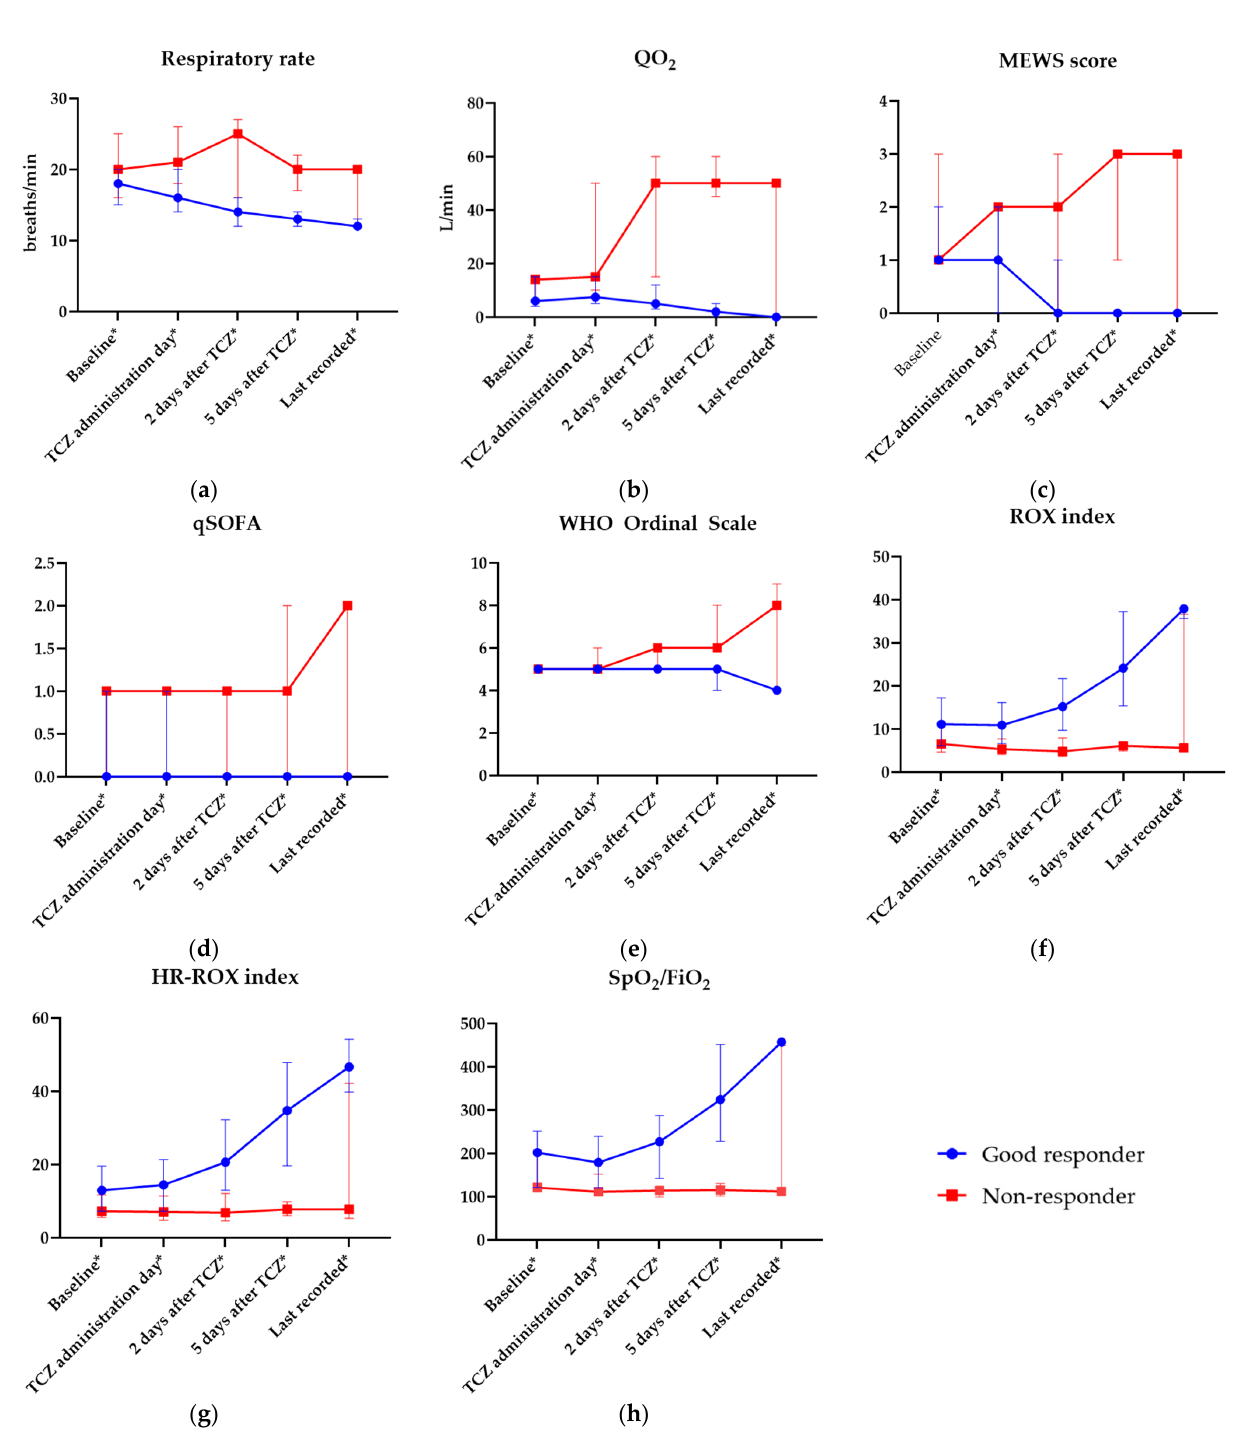
Figure 1. Clinical parameters and complex indices measured during hospitalization in clinical (good) responders and non-responders. Statistically significant differences are bolded and marked with *. ( a ) Respiratory rate (breaths/min); ( b ) oxygen flow (QO 2 , L/min); ( c ) Modified Early Warning Score (MEWS); ( d ) Quick Sepsis-Related Organ Failure Assessment (qSOFA) score; ( e ) World Health Organization (WHO) Ordinal Scale; ( f ) ROX index; ( g ) modified ROX index (HR-ROX); ( h ) ratio of SpO 2 —peripheral oxygen saturation and FiO 2 —fraction of inspired oxygen. Points represent median values of variables and whiskers reflect interquartile ranges